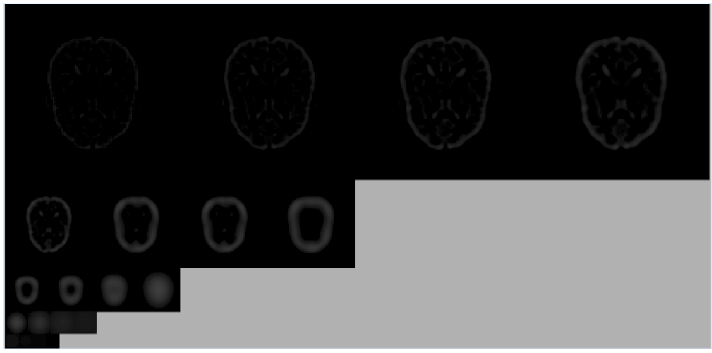
Figure 3. An instance of difference of Gaussian